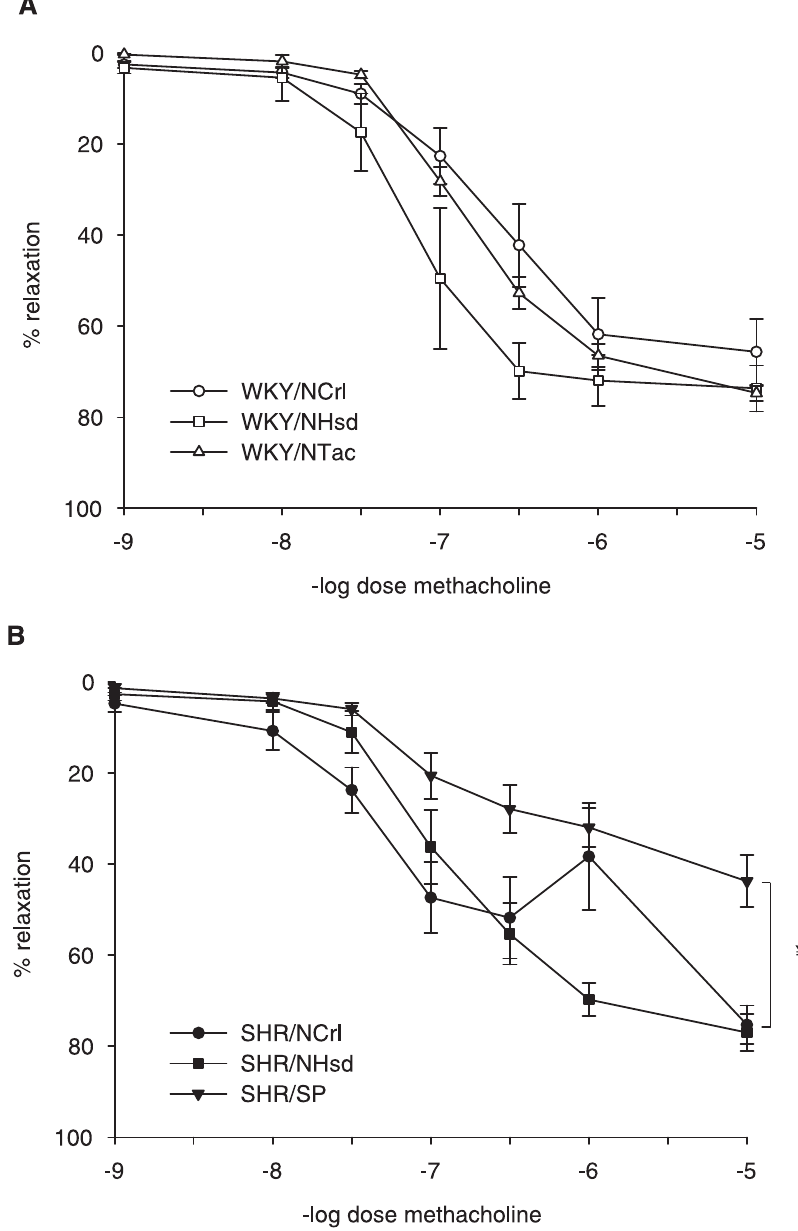
Figure 4. Endothelial function. To test endothelium-dependent relaxation, vessels of WKY sublines (panel A) and SHR sublines (panel B), were mounted in a wire myograph and contracted with 3 ? 10 2 7 mol/L thromboxane analogue U46619. Then, increasing doses of methacholine were added to the vessel bath. Data are mean 6 SEM with n $ 5 animals. { Indicates P , 0.05 for SHR/NCrl vs. SHR/SP. ¥ Indicates P , 0.05 for SHR/NHsd vs.